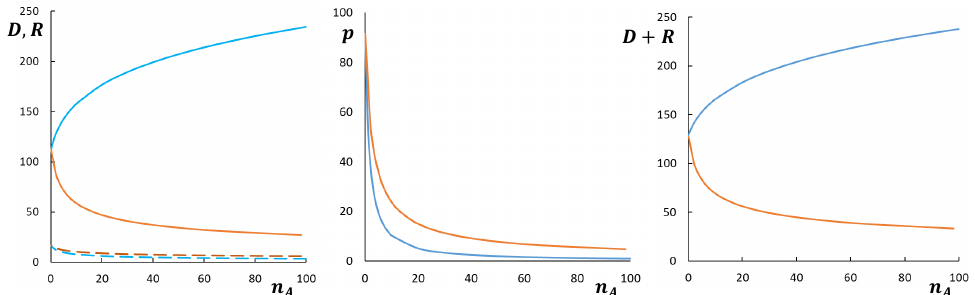
Figure 4. Aggregation number p , core radius R (dashed lines), and corona thickness D (solid lines), and overall radius, R + D , of starlike spherical micelles formed by block copolymers with N B = 200 and N A = 1000 or M A = 1000 as a function of n A (cross-section (1) in Figure 3a). Red and blue curves correspond to N A = 1000 = const (varied n A , M A ) or to M A = 1000 = const (varied n A , N A ), respectively. Other parameters are q A = 1, m A = 2, γ = 1, v = 1, φ B = 1.